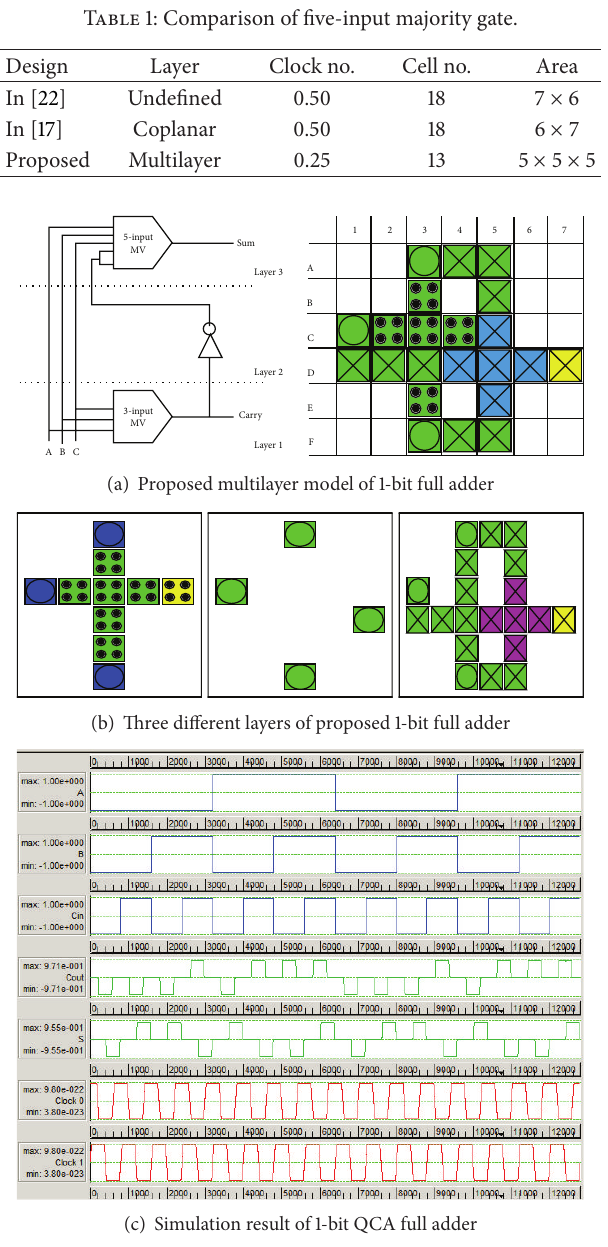
Figure 5: QCA implementation of the proposed full adder and its simulation